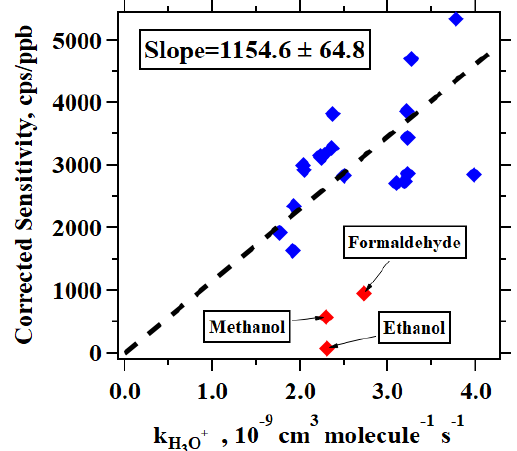
Figure 3. Corrected sensitivities as a function of kinetic rate con- stants for proton transfer reactions of H 3 O + with VOCs. The dashed line indicates the fitted line for blue points. The red points not used as these compounds (formaldehyde, methanol, and ethanol) are known to have lower